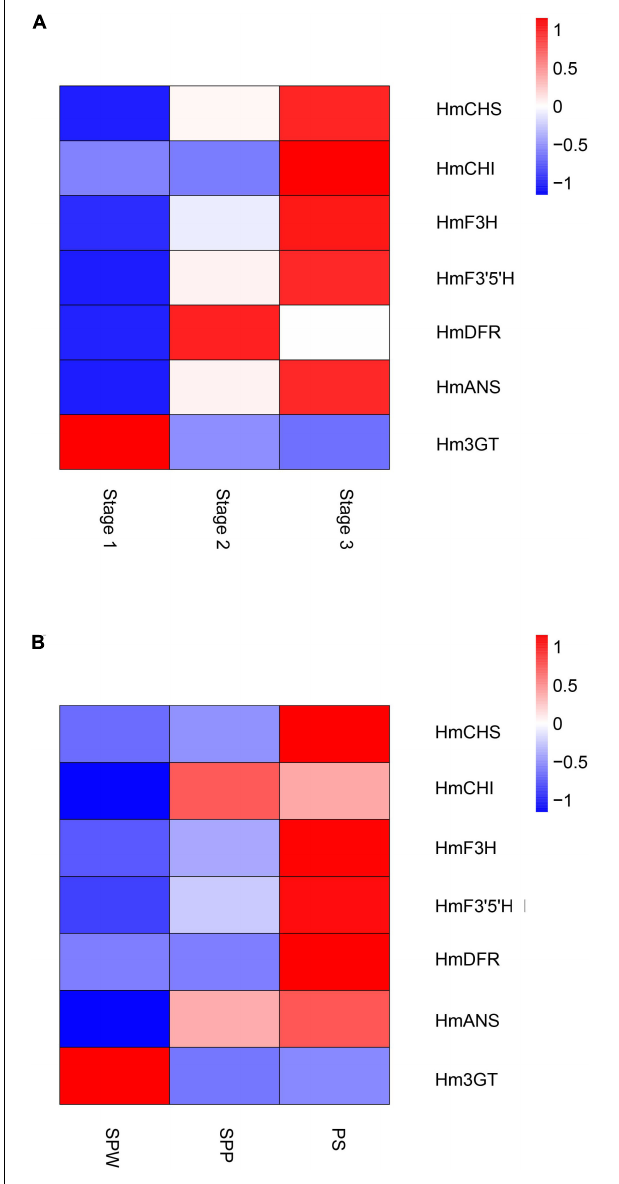
FIGURE 6 | Heatmaps show the expression of key genes in the anthocyanin biosynthesis pathway of H. mutabili s. (A) Gene expression changes in flowers of H. mutabilis ‘Drunk girl’ as their color transitions from white to fully pink. (B) Gene expression in flowers of three different color cultivars: ‘single-petal white’ (SPW), ‘single-petal pink’ (SPP), and ‘Purple silk’ (PS).